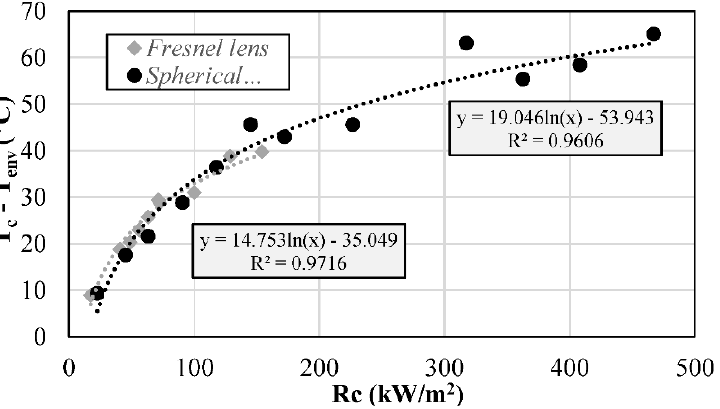
Figure 12. Increase of the TJ cell temperature as a function of the concentrated solar radiation (R c ) for the two optics.